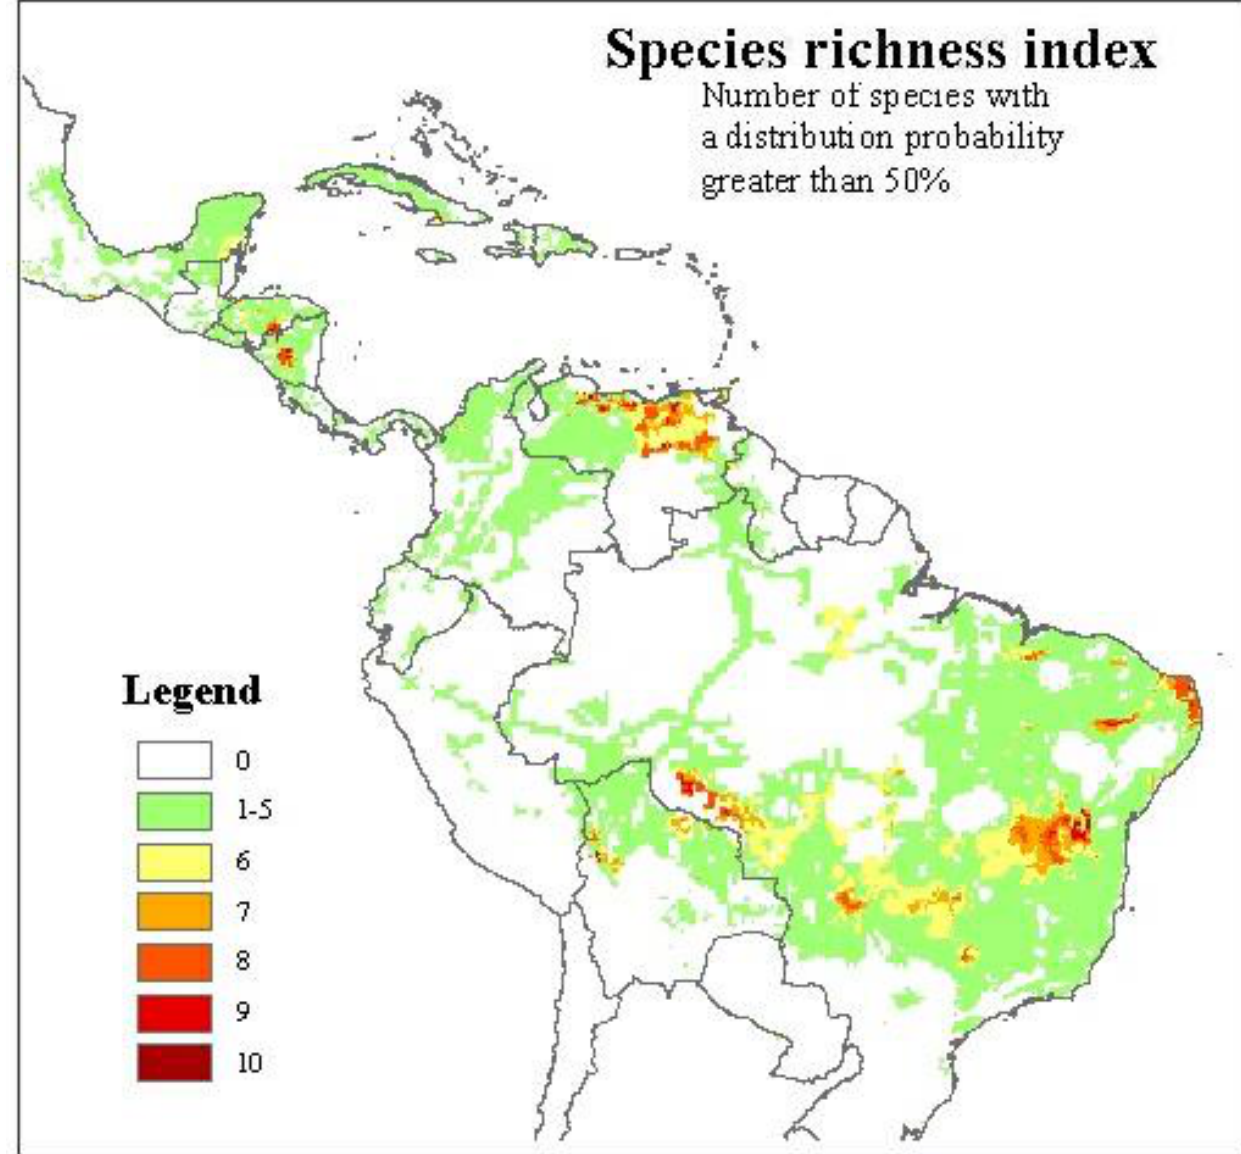
Fig. 5 . Potential areas for in situ conservation outside areas of origin. The concentration of species whose probability of finding an environment similar to their areas of origin is greater than